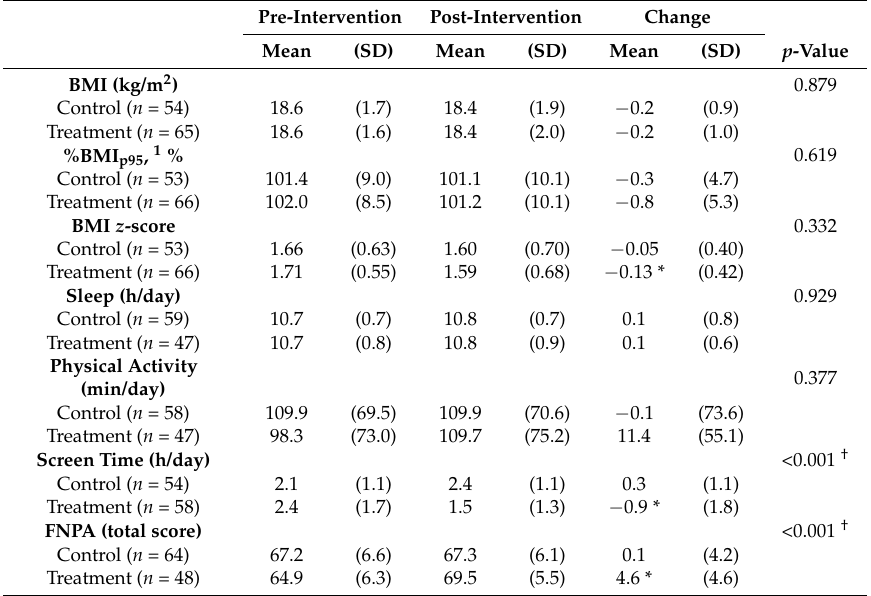
Table 2. Changes in body mass index (BMI) and behaviors among children 2–5 years participating in a primary care weight management program.